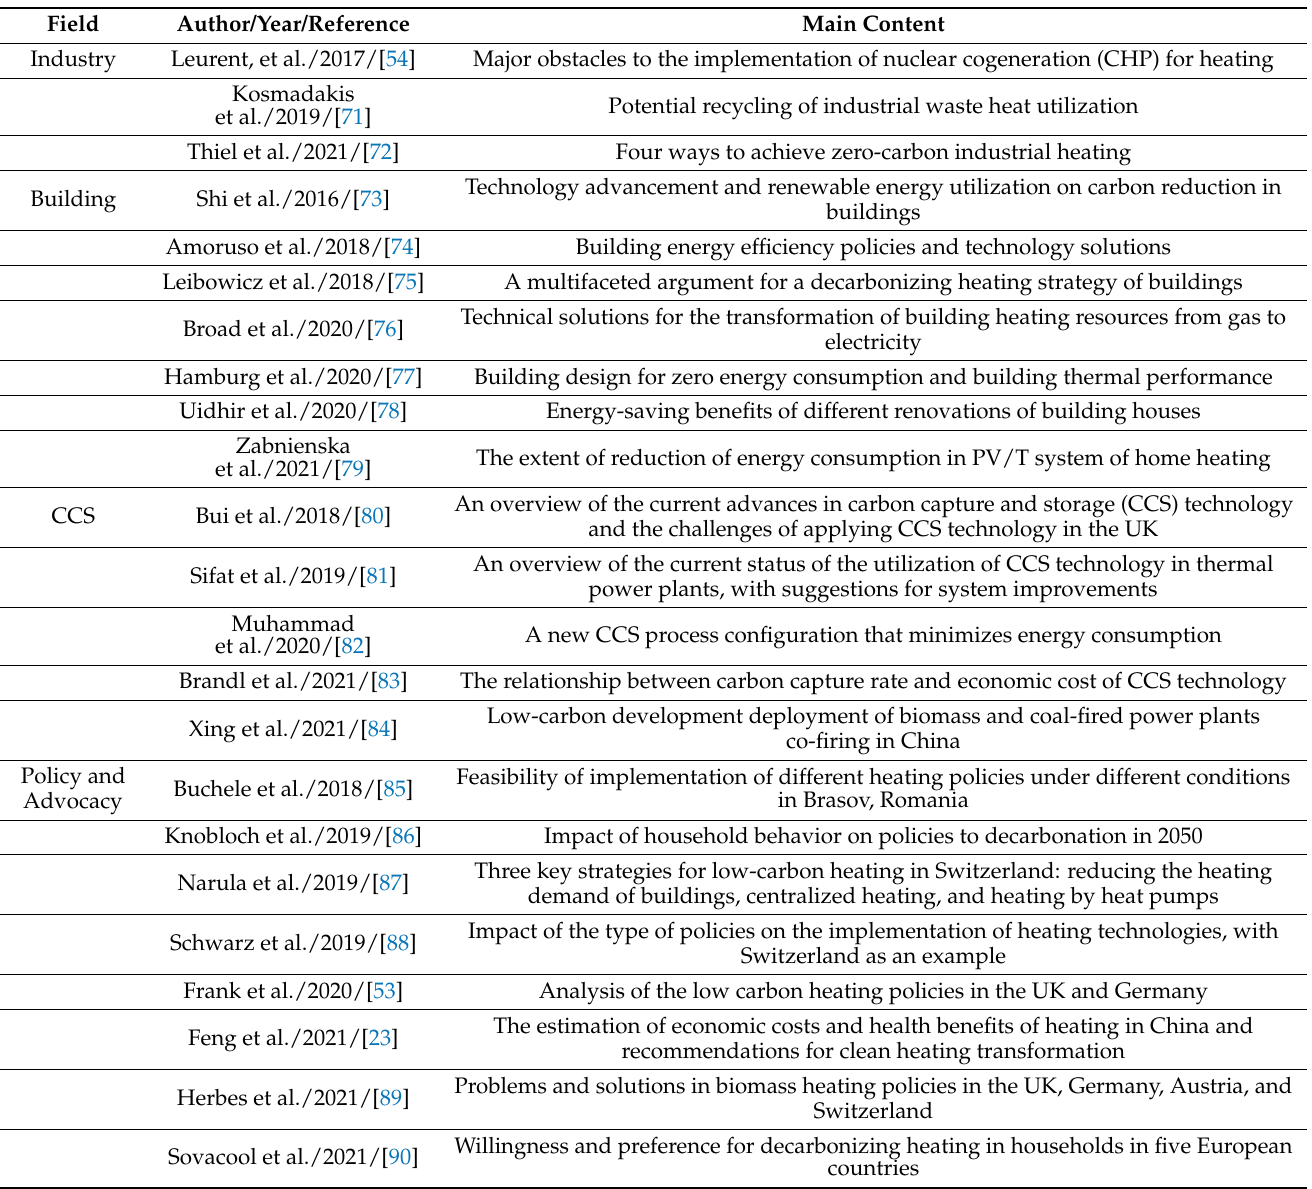
Table 4. The development of heating supports at home and abroad in the last five